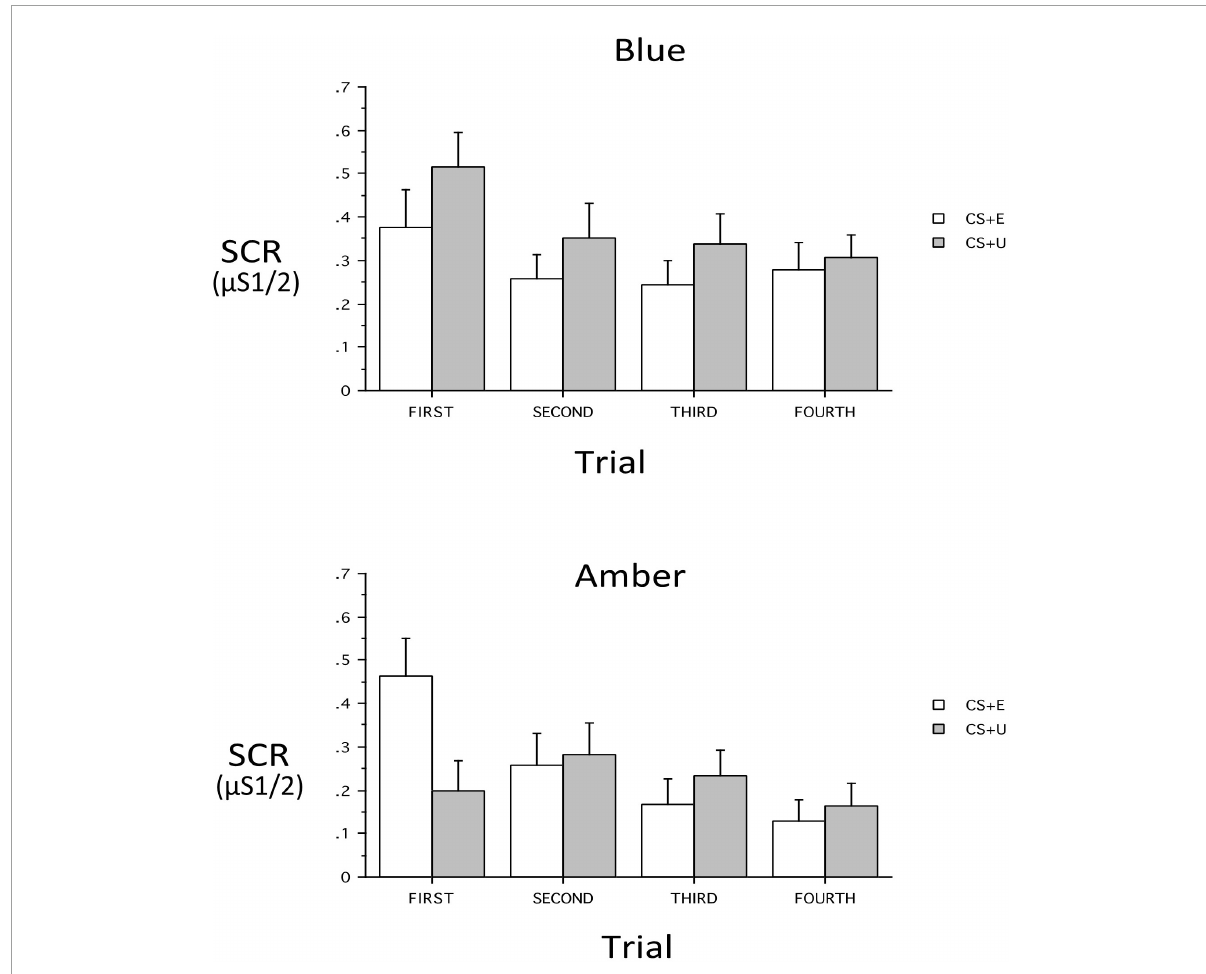
FIGURE5 Skin conductance responses (SCR) across trials for the blue light treatment-BLT (top) and amber light placebo treatment-ALT (bottom) for the extinguished (CS + E) versus unextinguished (CS + U). The BLT condition led to reduced SCR to extinguished relative to unextinguished stimuli (especially on the first trial), while the opposite was true for the amber placebo condition. µ S, microSiemens. Error bars represent standard error of the